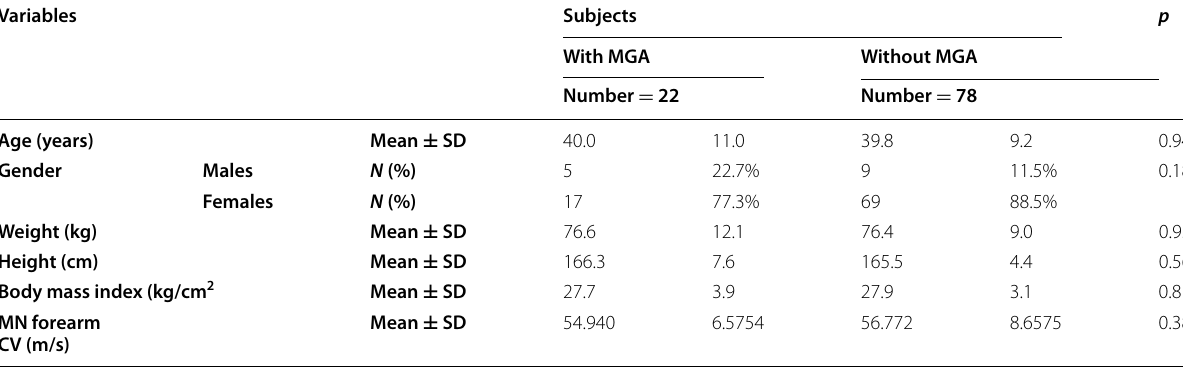
MGA Martin–Gruber anastomosis, N number, P value probability value, SD standard deviation, MN median nerve, CV conduction velocity, p > 0.05 difference Table 3 Comparisons among CTS patients (group IB) with and without MGA regarding their studied data Variables